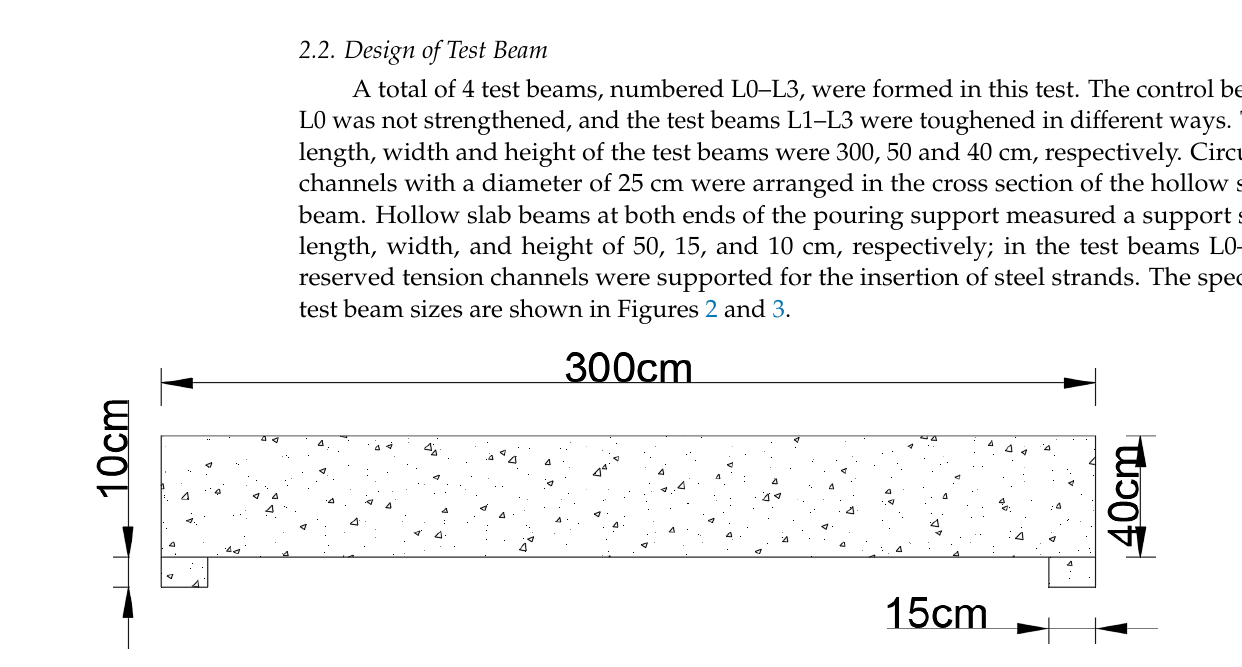
Figure 2. Longitudinal section of the test beam.